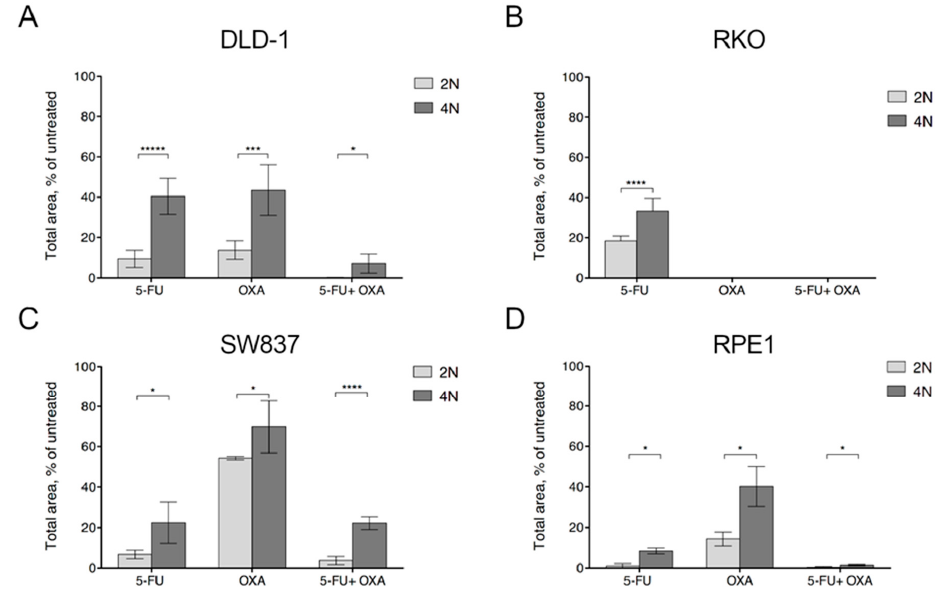
Figure 3. Clonogenic capacity of 2N and 4N cells after treatment with first-line chemotherapeutic agents. Graphs showing the clonogenic capacity in one 2N and two 4N clones of DLD-1 ( A ), RKO ( B ), SW837 ( C ) and RPE1 ( D ) cells treated with 5 µM 5-fluorouracil, 5 µM oxaliplatin or the combination